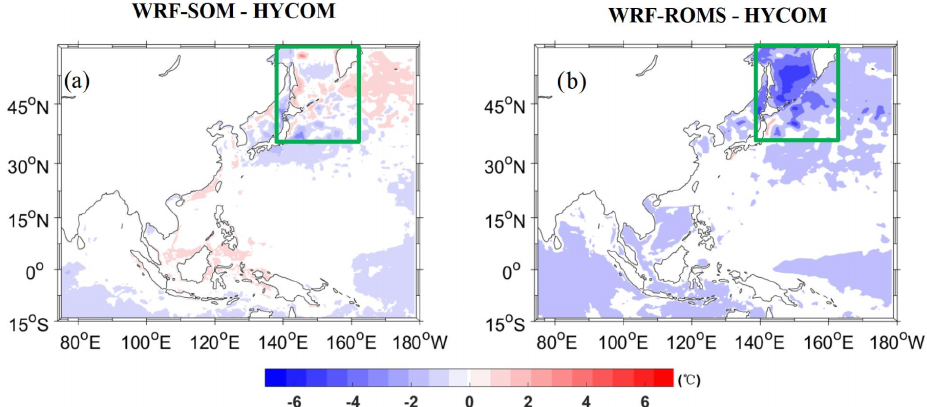
Figure 3. The spatial distributions of the SST errors of (a) WRF-SOM, and (b) WRF-ROMS against the HYCOM reanalysis of total 142 forecast cases from 19 July to 31 December 2020 averaged in the 34d forecast period. The region in the green rectangle (35–58 ◦ N, 140– 160 ◦ E) is the cold deviation area in